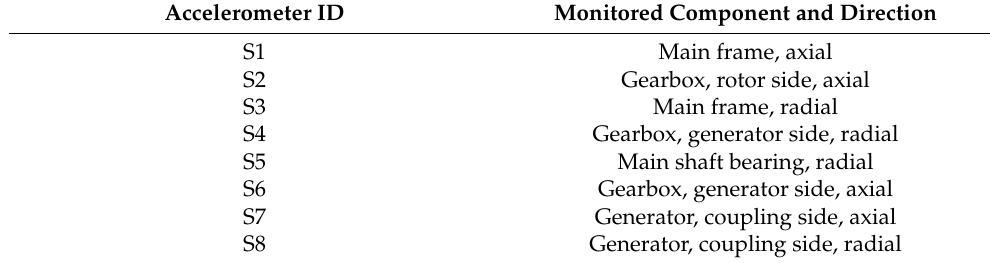
Table 2. The monitored components and measured acceleration directions in the two wind turbines.